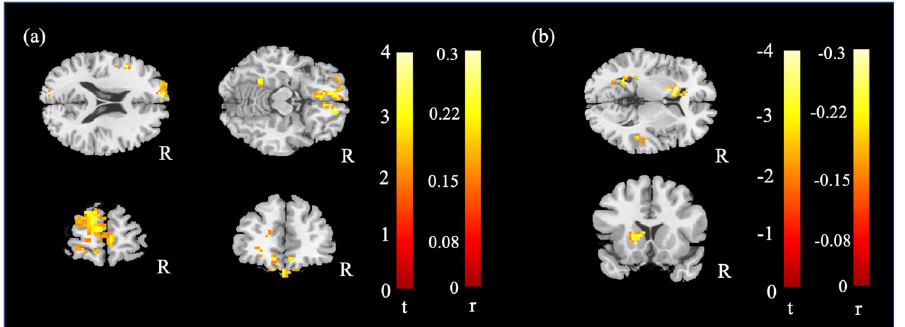
Fig 3. Multiple regression results between mfALFF and PHQ-9 score displayed that (a) positive correlation in PFC (b) negative correlation in left caudate (cluster size > 50, corrected p < 0.05, color bar, t scores, r scores).